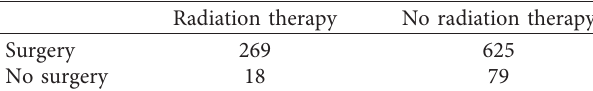
Table 3: Summary of treatment: multimodality treatment with radiation.